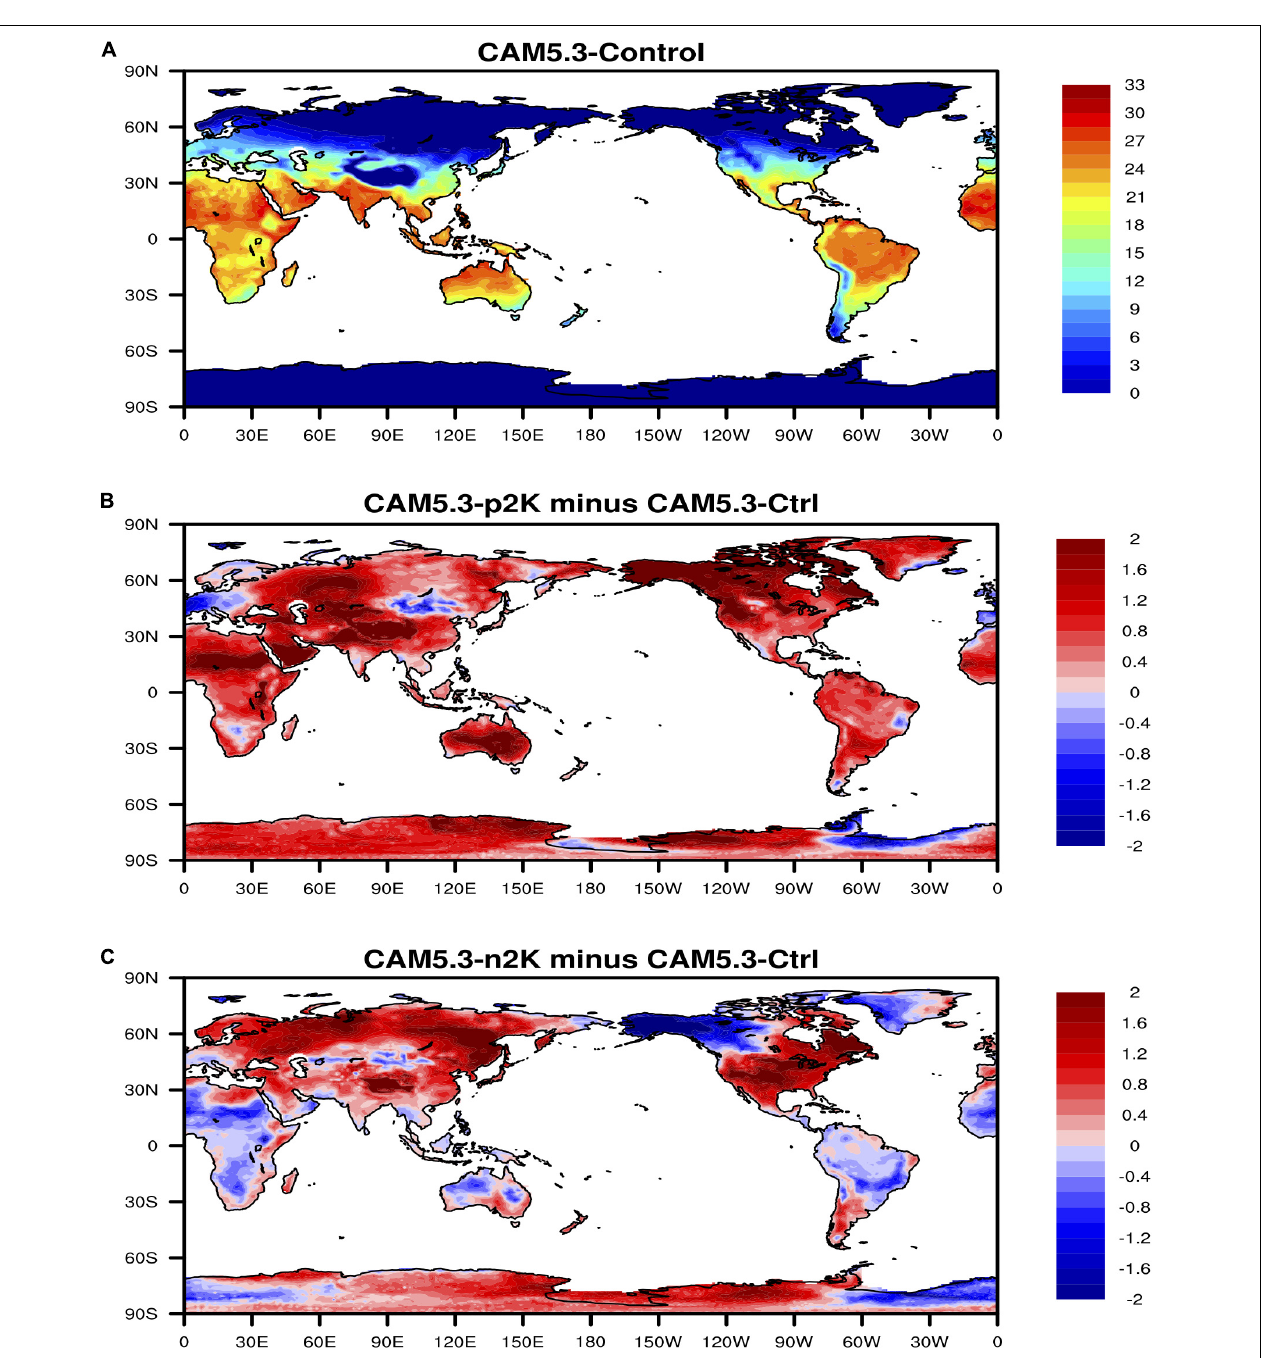
FIGURE 5 | (A) Land surface air temperature in the CAM5 control run. (B) Anomalies of surface temperature in the CAM5 + 2K run with respect to the control run. (C) Anomalies of surface temperature in the CAM5-2K run with respect to the control run. Unit of temperature is ◦ C.